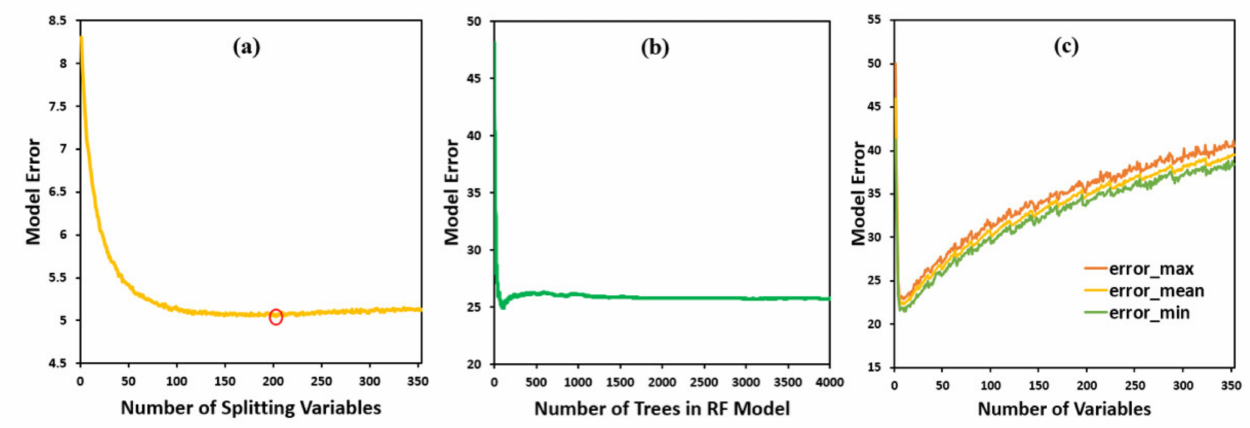
Figure 3. ( a ) Influence of mtry on model error (Mg ha − 1 ); ( b ) influence of ntree on model error (Mg ha − 1 ); ( c ) influence of the number of variables on model error (Mg ha − 1 ).